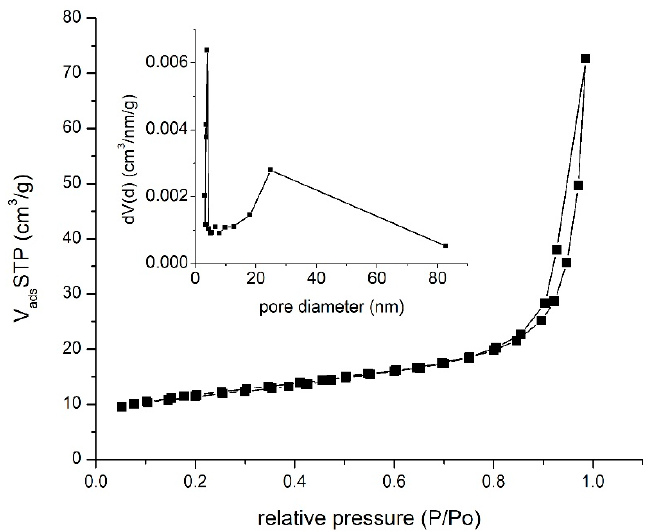
Figure 5. Nitrogen adsorption desorption isotherms obtained for sample BCb/CB. Inset presents the pore size distribution.